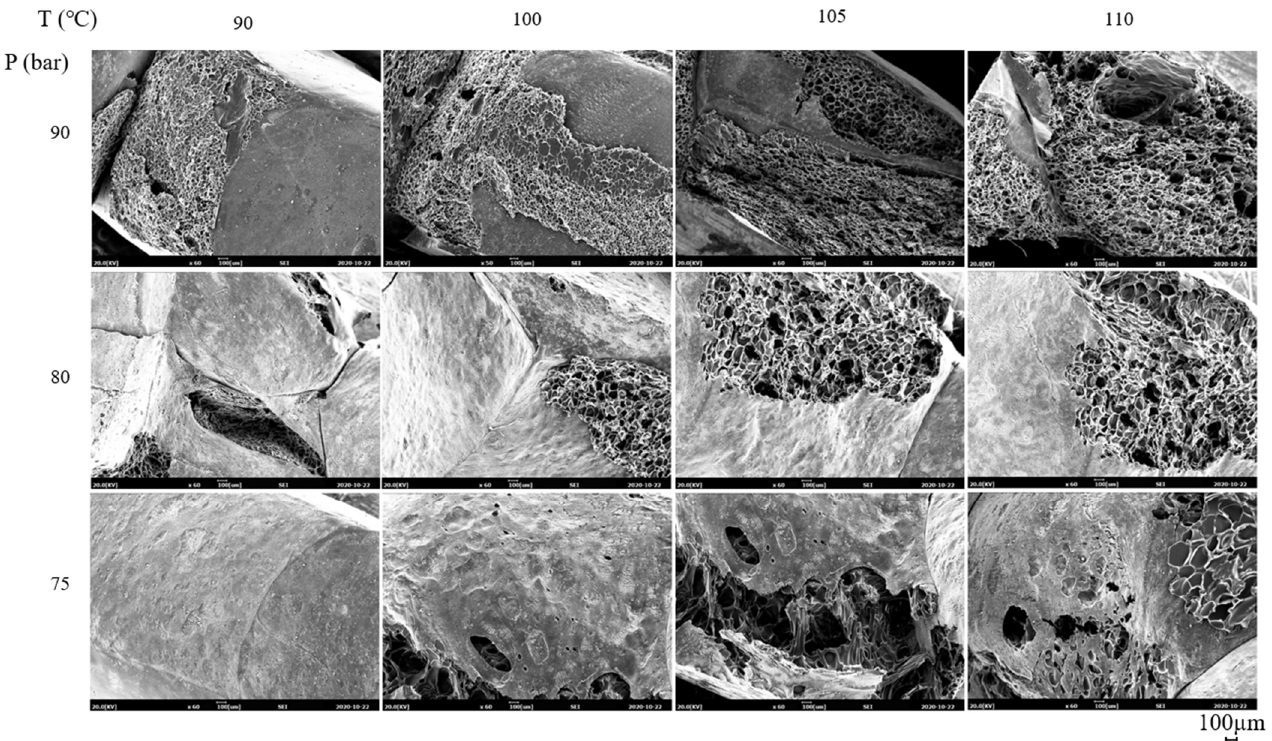
Figure 12. SEM micrographs of the fracture surface of ETPU foam sheets from tensile testing.